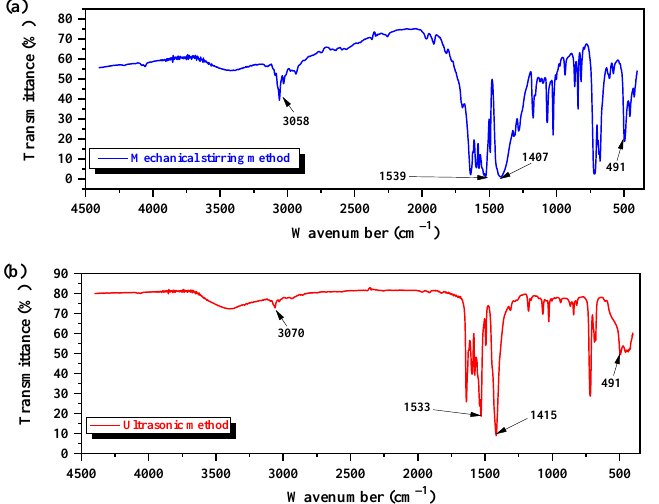
Figure 4. FTIR spectra of nano-ZnO. ( a ) By mechanical stirring method; ( b ) by ultrasonic method.